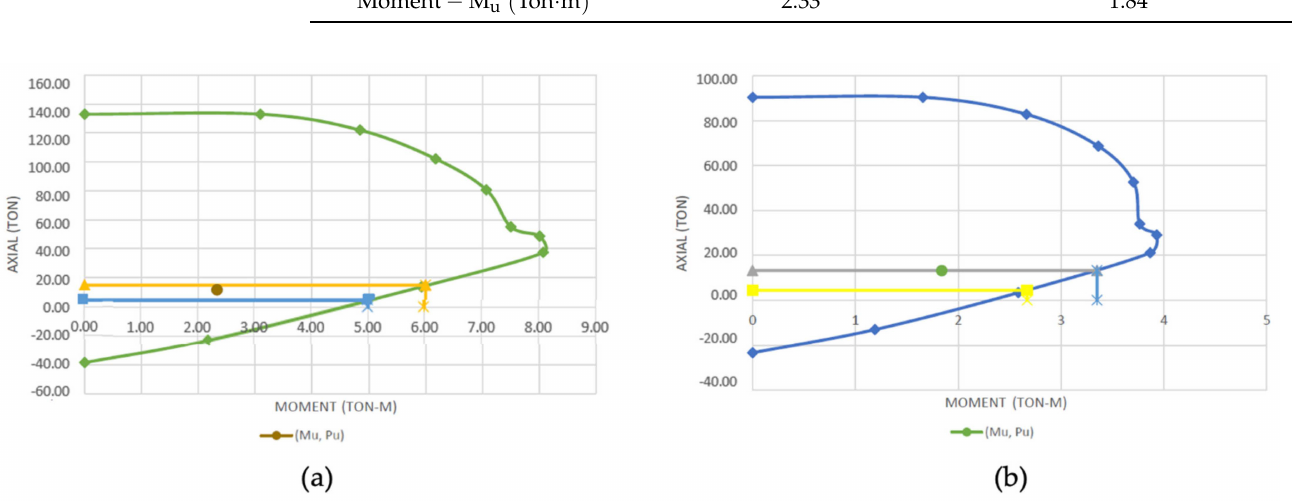
Figure 5. Interaction diagram: ( a ) option 1, ( b ) option